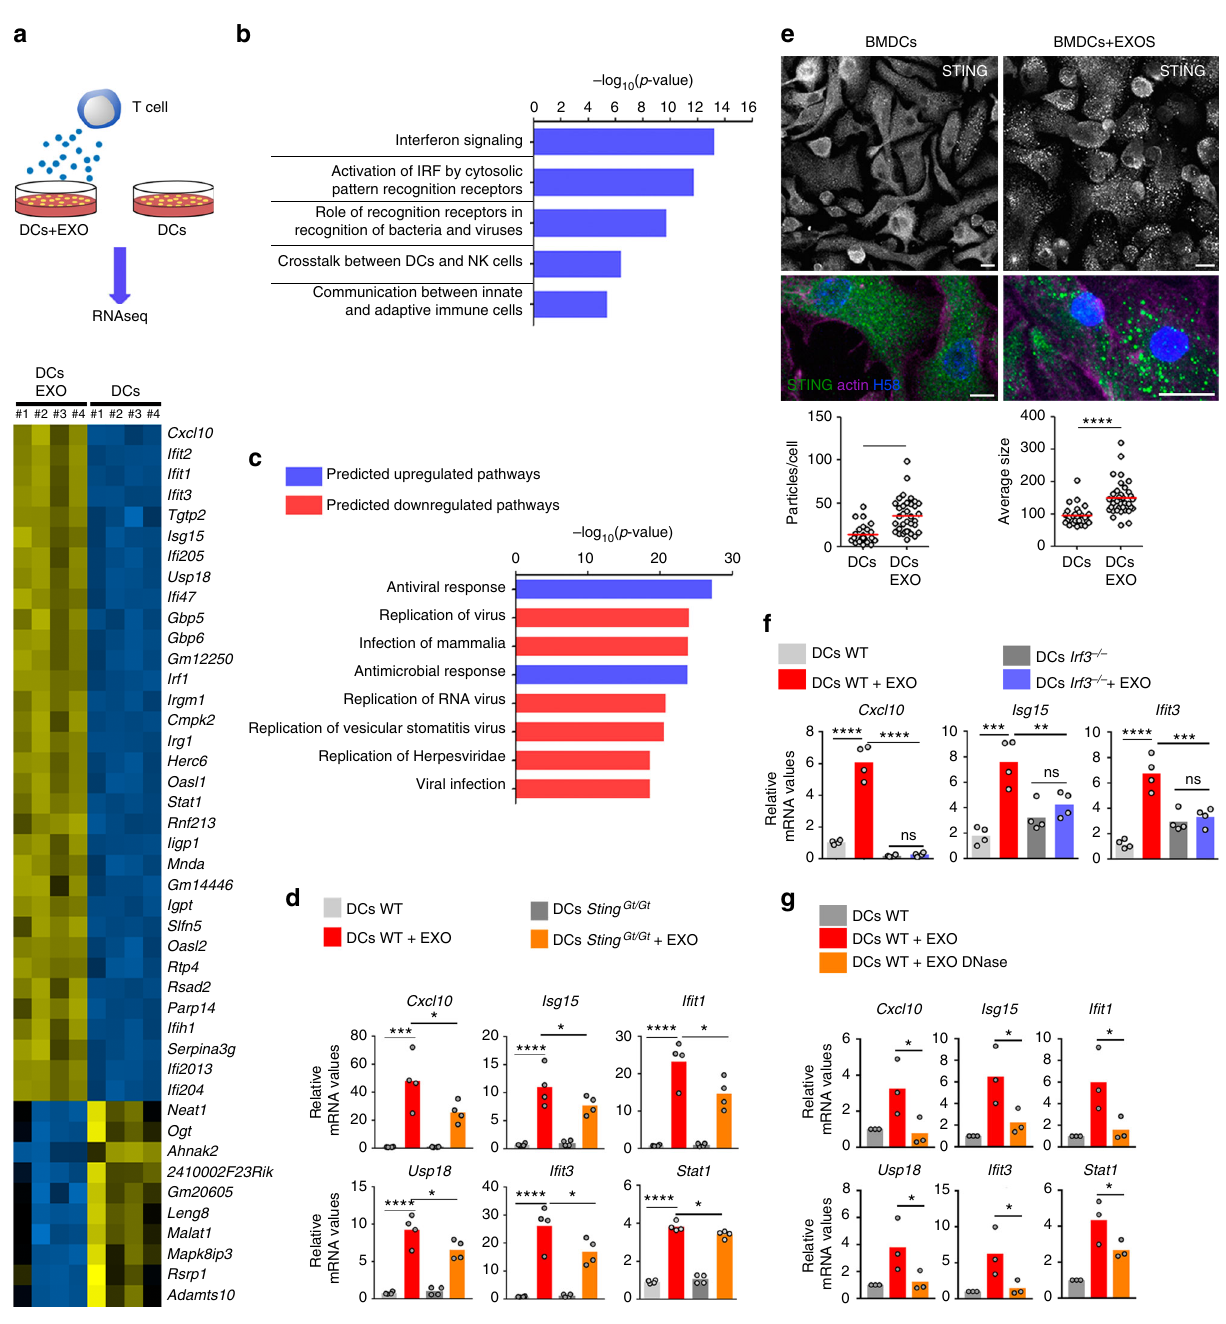
Fig. 5 Exosomes prime antiviral innate immune responses in DCs. a Upper panel: Work fl ow for RNAseq analysis of DCs upon T cell exosome acquisition. Lower panel: RNAseq heat maps of four DC biological replicates with or without exosome uptake (DCs + EXO vs DCs). The panel shows upregulated (yellow) or downregulated (blue) genes with the highest signi fi cant fold changes. b GO annotation of the biological processes differently regulated upon exosome addition; p -values are presented for the top-ranking biological processes. c Ingenuity analysis predictions of DC pathways upregulated or downregulated upon acquisition of T cell exosomes. d Quantitative real-time PCR (qRT-PCR) of antiviral response genes in wild-type DCs and Sting Gt/Gt DCs upon exosome addition. Mean, n = 4, t -test *** P -value < 0.0001 and **** P -value < 0.00001. e Upper panel: Immuno fl uorescence microscopy images showing STING aggregation (green) in DCs upon exosome addition. For clarity, DCs were stained for actin with phalloidin (purple) and for nuclei with HOECHST 58 (blue). Bar, 10 µ m. Lower panel: Quanti fi cation of STING aggregate size and number upon exosome addition. Mean, n = 26 (control), 35 (STING), t -test *** P -value < 0.0001 and **** P -value < 0.00001. f qRT-PCR analysis of antiviral response genes in wild-type DCs and Irf3 − / − DCs upon exosome addition. Data ( d , f ) show quanti fi cation of mRNA levels of a representative experiment with four mice per genotype: t -test * P -value < 0.05, ** P - value < 0.001, *** P -value < 0.0001, and **** P -value < 0.00001. g qRT-PCR analysis of antiviral response genes in wild-type DCs upon addition of exosomes left untreated or pre-treated with DNase. Data shows mean from three independent experiments. t -test * P -value <